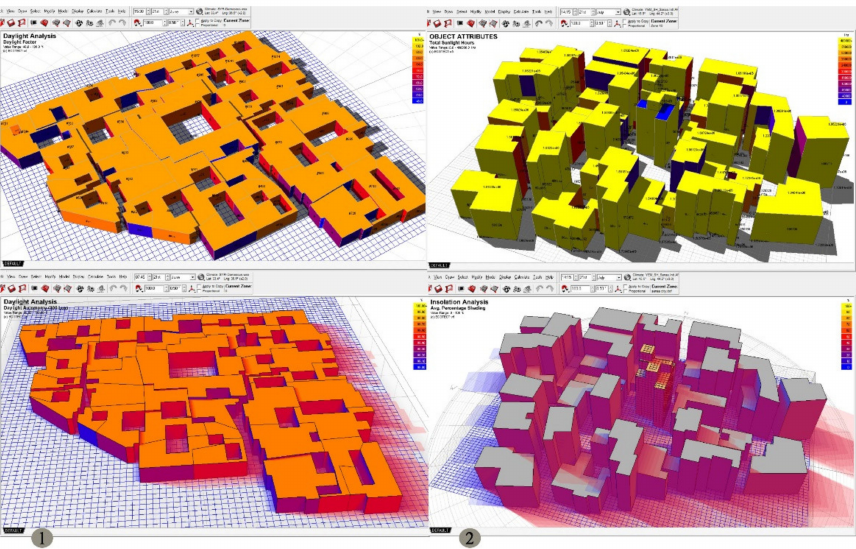
Figure 10. Shading level analysis of urban fabric in ( 1 ) old Damascus, ( 2 ) old